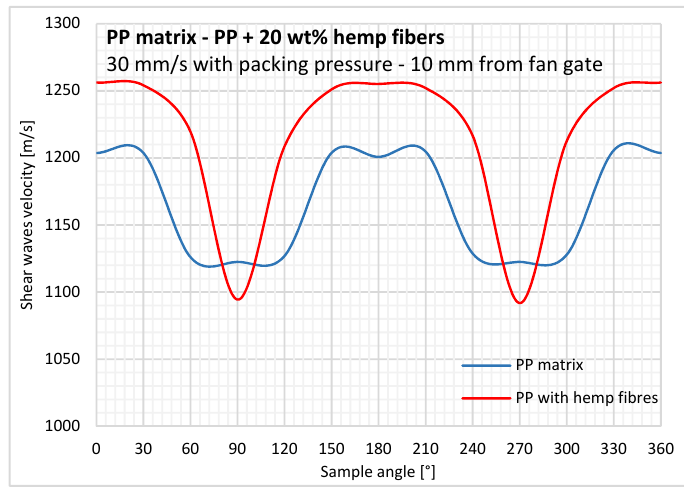
Figure 11. Shear wave velocity changes over a 360° rotation for the neat PP matrix and PP reinforced with hemp fibers.